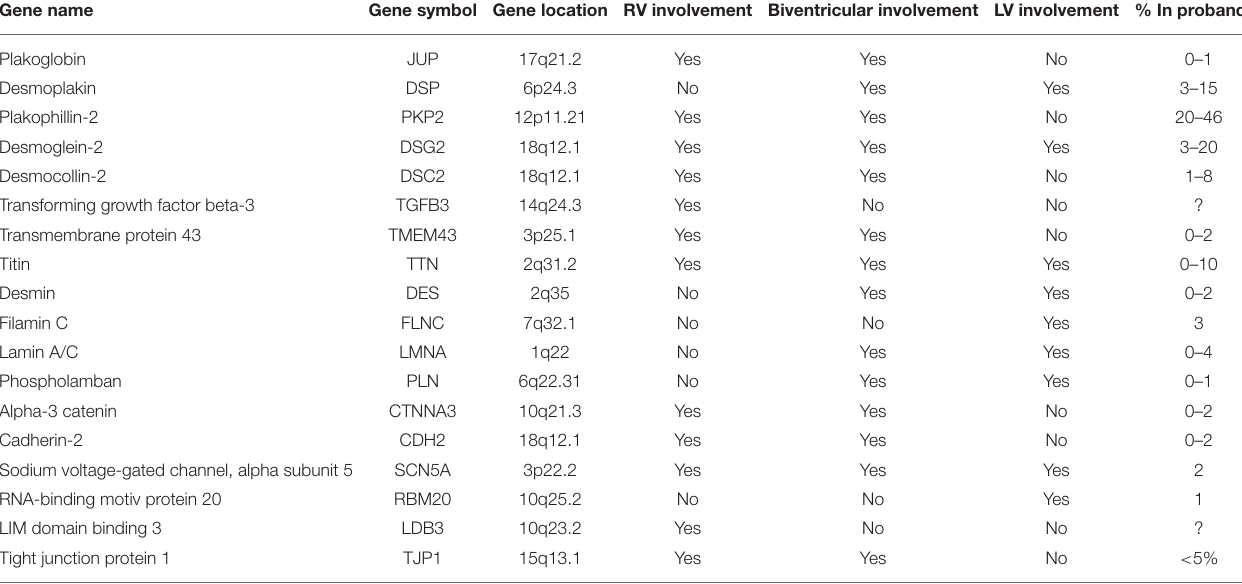
TABLE 1 | List of arrhythmogenic cardiomyopathy-causing genes and the main characteristics of their phenotype.